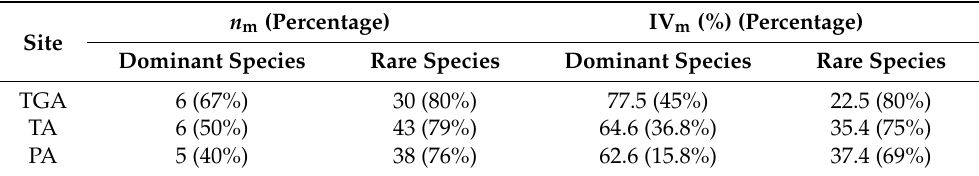
Table 2. Number and importance value (IV) of mesophytic species and their proportion in the dominant (IV > 5%) and rare (IV < 5%) species at three sites subject to different levels of disturbance in the KGTA and YWNR, Beijing Municipality,